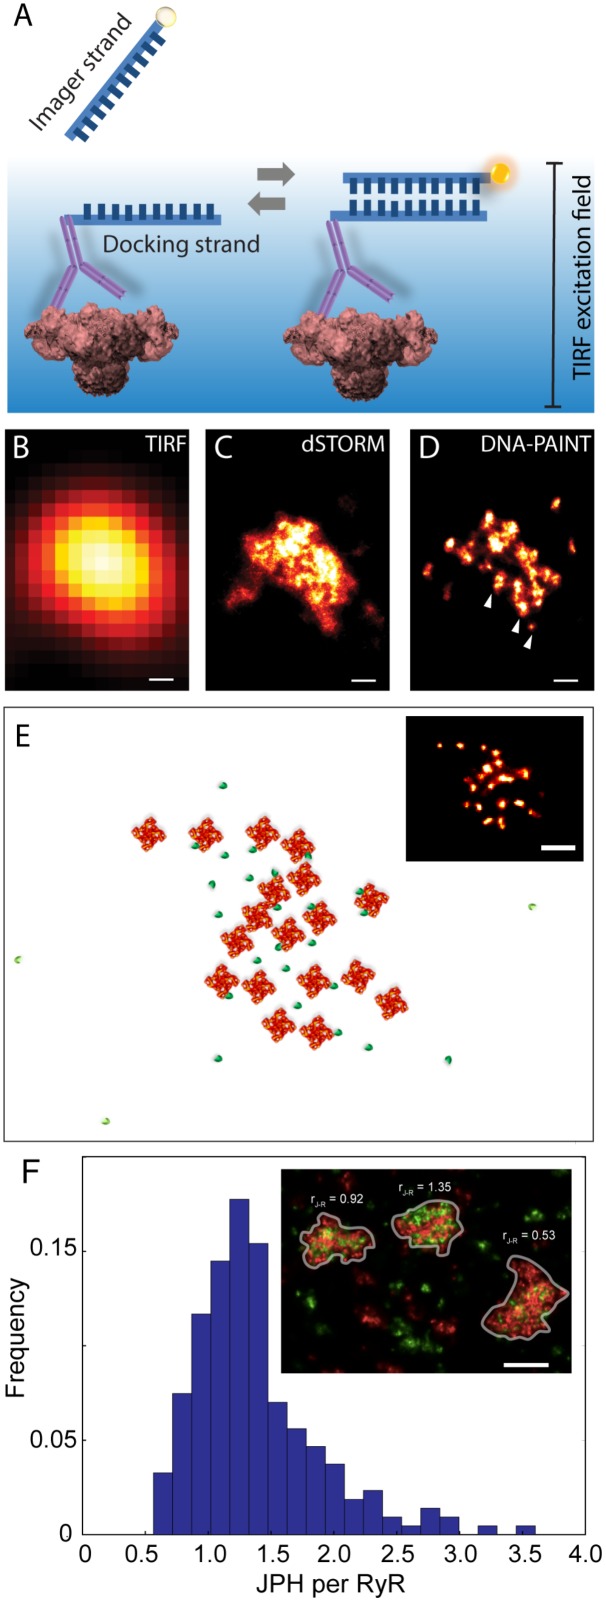
Adaptation of DNA-PAINT to mapping RyR in peripheral couplons of rat cardiomyocytes. (A) DNA-PAINT relies on the thermally driven stochastic and reversible binding between a fluorescently labelled ‘imager’ DNA oligo and a ‘docking’ DNA oligo which in this scenario is linked to the anti-RyR antibody. Markers near the cell surface are illuminated with a TIRF excitation field. Shown, is a comparison of (B) conventional TIRF, (C) dSTORM and (D) DNA-PAINT images of an RyR cluster, highlighting the detection of finer punctate labelling densities which are unique to the latter (arrowheads). (E) Example of an approximate reconstruction of individual RyR arrangement (red) and hypothesised accessory proteins such as JPH2 (green) based on the RyR positions reported by an experimental DNA-PAINT image of a peripheral couplon (inset). (F) Histogram illustrating the distribution of JPH2 to RyR ratios [mean 1.38, mode at 1.25 and a width of 0.5 (standard deviation), n = 250 clusters (containing ≥ 15 RyRs)]. Inset illustrates examples of three adjacent couplons exhibiting JPH2/RyR ratios ranging between 0.53 and 1.35 (RyR shown in red and JPH2 in green). Scale bars: (B–D): 50 nm, (E): 100 nm, (F): 250 nm. All panels adapted from Jayasinghe et al. (2018).